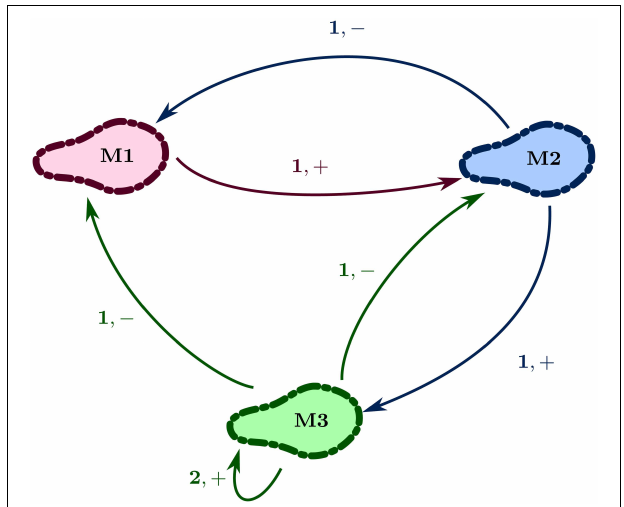
FIGURE 2 | Regulatory network of Case Study 1: Microbial population.